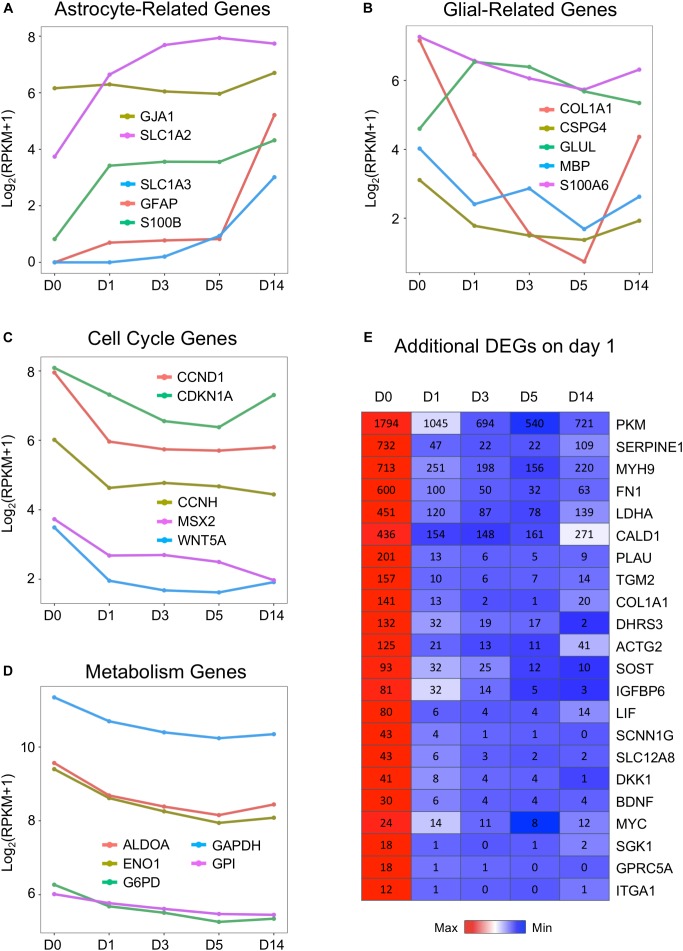
Downregulation of cell cycle and metabolic genes by small molecules. (A,B) Representative glial marker genes during chemical reprogramming process. The small molecule treatment did not change the transcriptional level of GFAP and S100B. The glutamate transporters (SLC1A2 or EAA2/GLT-1 and SLC1A3 or EAA1/GLAST) were upregulated, whereas COL1A1 (collagen) and CSPG4 (NG2) were downregulated. (C) Genes related to the cell cycle process showed decreased expression, with a significant drop at D1. (D) Genes involved in glycolysis (ALDOA, ENO1, GAPDH, G6PD) were uniformly downregulated by small molecule treatment. (E) Heat map of representative genes showing significant downregulation during the chemical conversion process. Color scaled within each row and FPKM values are presented. Red color indicates highest expression level within each row, whereas blue color indicates low expression level within each row.